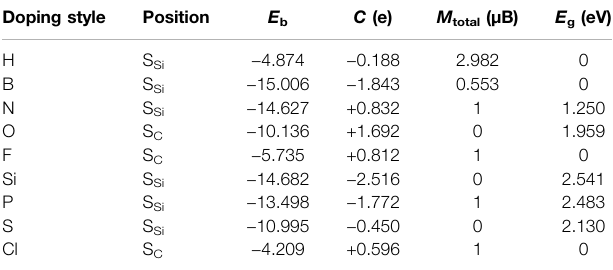
TABLE 1| The doping position, binding energy ( E b ),chargetransfer ( C ),band gap ( E g ), and magnetic moment ( M total ) of the NM-SiC